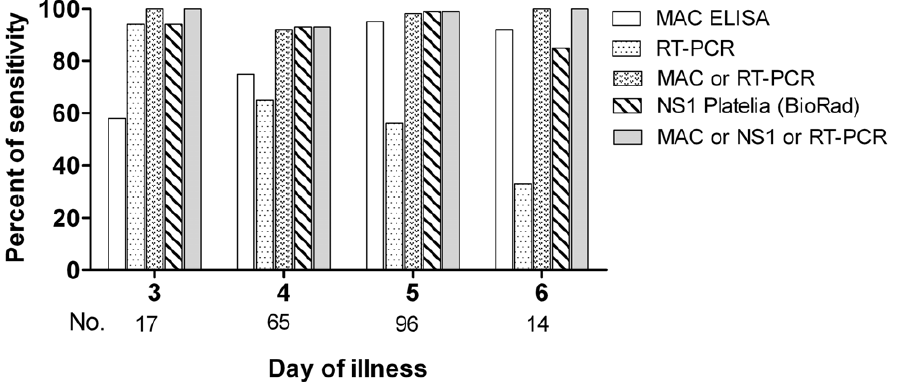
Figure 2. The sensitivity of diagnostic tests in acute DENV infection of infants. The number of patients evaluated on each day of illness is shown below the graph. Bars show the percentage of samples positive by each assay.